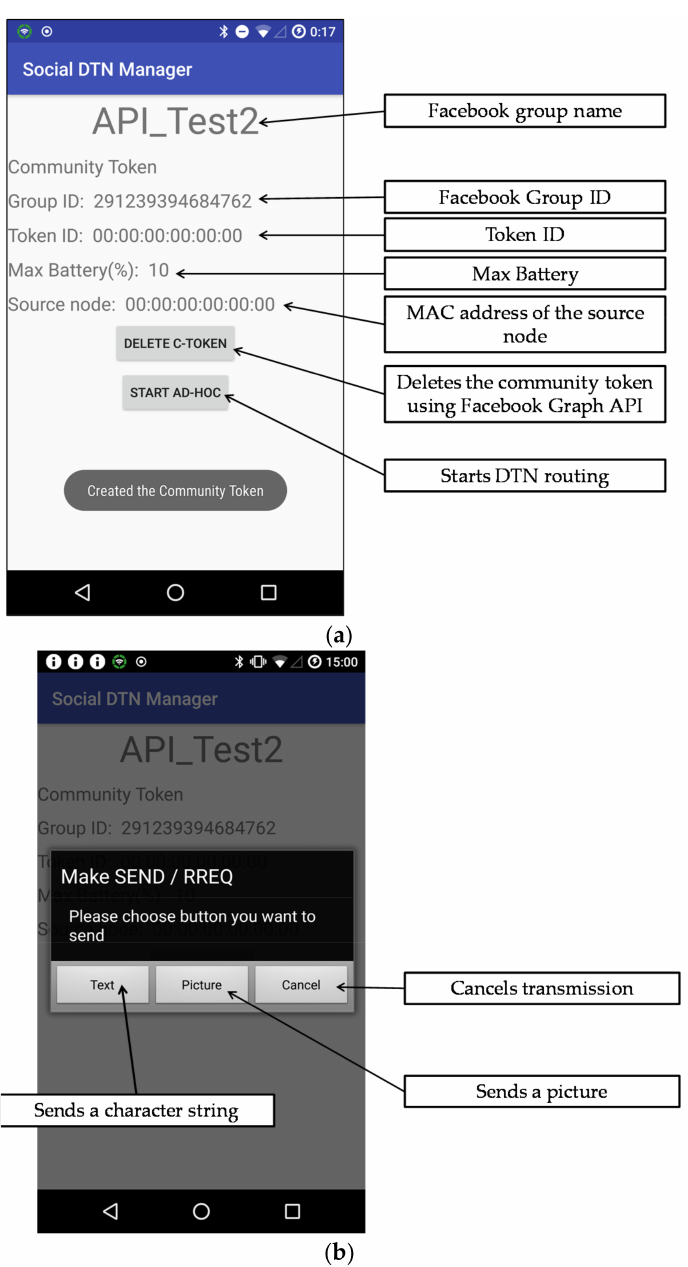
Figure 7. Graphical user interface (GUI) examples of the social DTN manager application developed. ( a ) GUI layout for linkage to Facebook after a community token has been created; ( b ) Message type selection dialog for sending text or